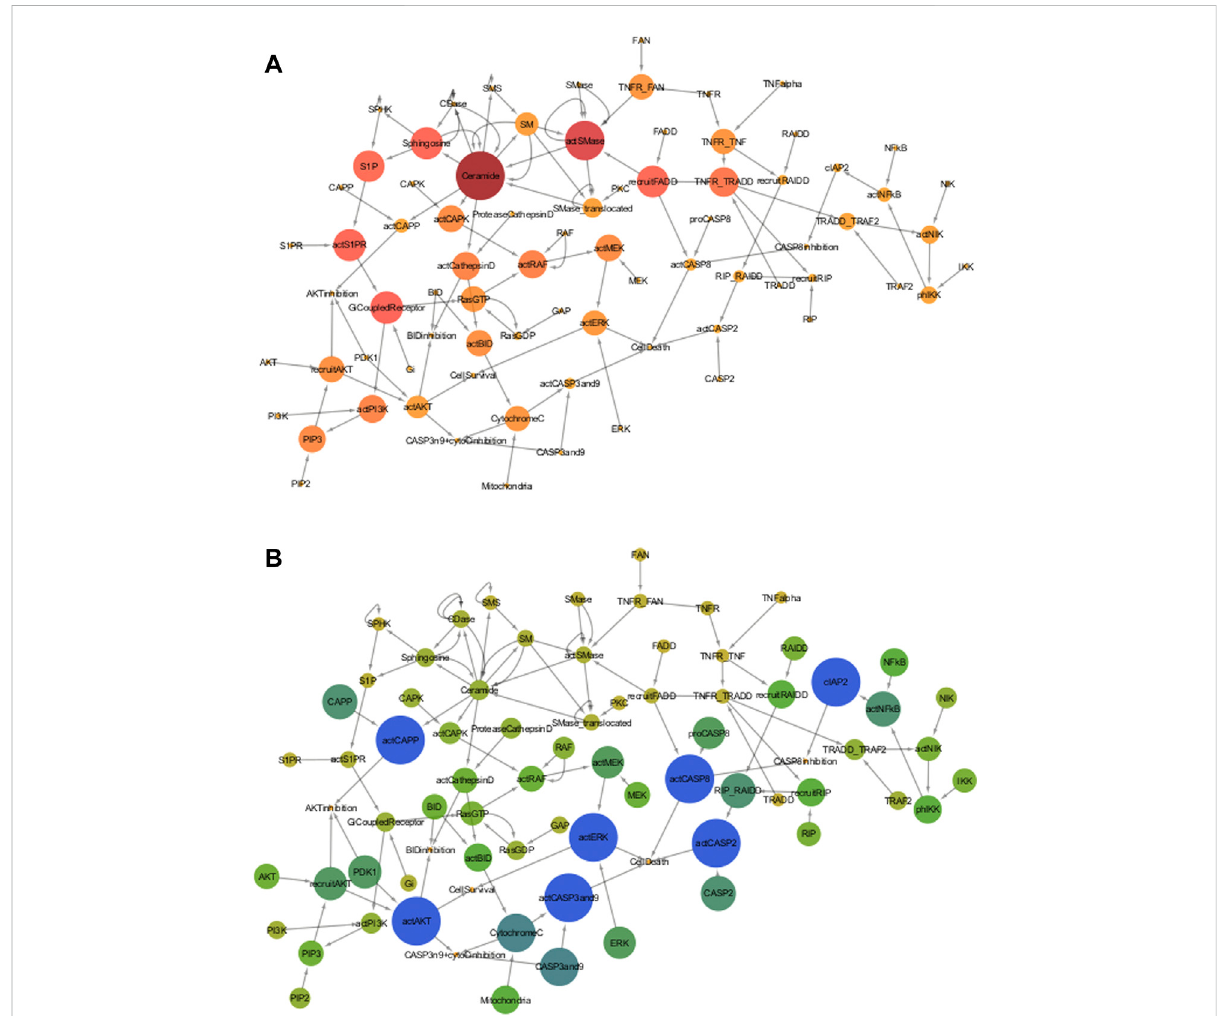
FIGURE 4 (A) Betweenness Centrality of TNF- α mediated sphingomyelin signaling pathway- Betweenness Centrality of a node represents the number of shortest paths between other pair of nodes that pass through that node. In this fi gure, the betweenness centralities of the pathway entities are represented by the color and size of the nodes, varying from dark wine to amber yellow and large to small, respectively. Nodes with dark wine color andlargesizehavehighbetweennesscentrality,whereasnodeswithlightgoldencolorandsmallsizehavelowbetweennesscentrality.Colorof intermediate nodes vary from punch pink to amber. (B) Closeness Centrality of TNF- α mediated sphingomyelin signaling pathway- Closeness Centrality of nodes determines their average distance to all other nodes. The closeness centralities of the pathway entities are represented by the color and size of the nodes, varying from dark blue to yellow and large to small respectively. Dark blue nodes with large sizes have high closeness centrality, whereasyellowcolornodeshavingsmallsizeshavelowbetweennesscentrality. Colorofintermediatenodesvaryfrompinegreentolight